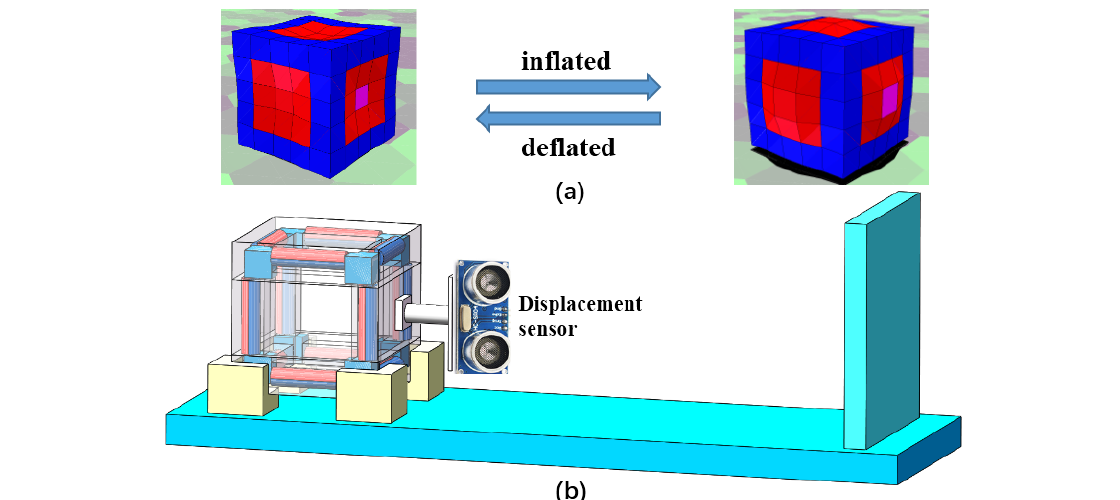
Figure 6. ( a ) Method of measuring the deformation of the soft cube in simulation software. ( b ) Diagram of measuring the deformation of the soft cube in the experiment.